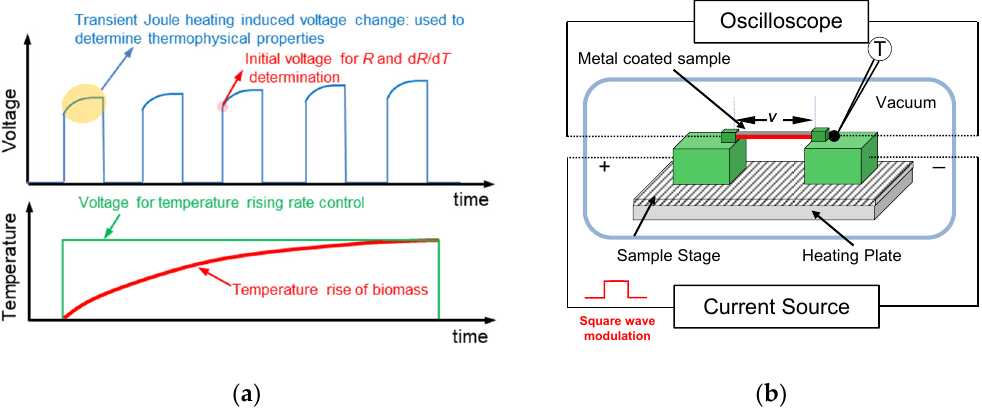
Figure 2. ( a ) Mechanism of the continuous in situ thermal characterization method. ( b ) A lab-developed, experimental setup for continuous thermal characterization.